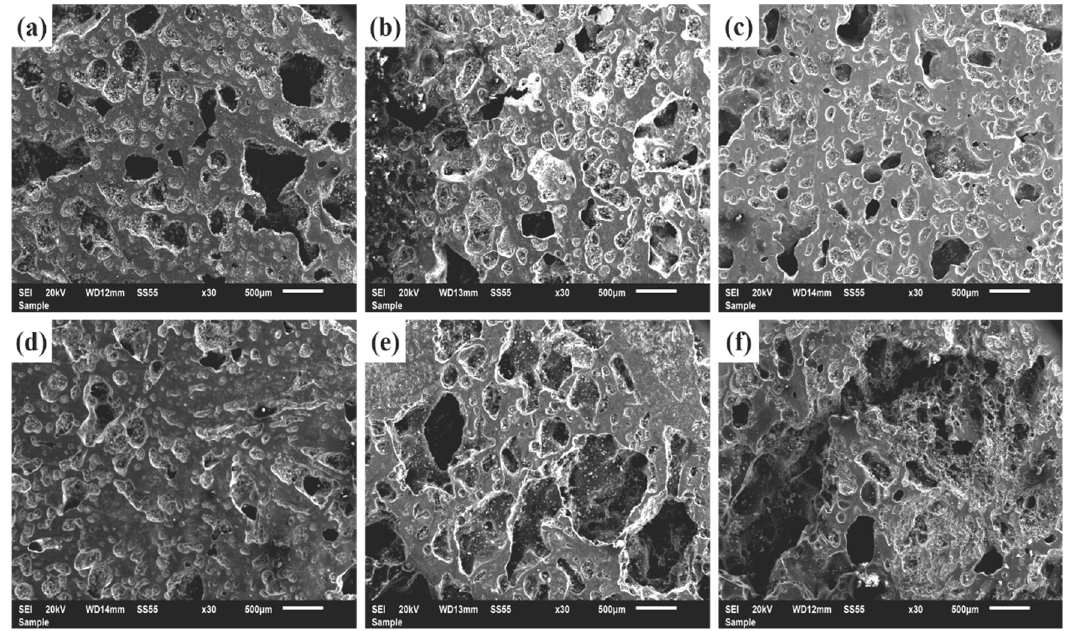
Figure 7. Micromorphology of coke after melting loss under CO 2 and H 2 O conditions. ( a ) Original sample; ( b ) 100%CO 2 ; ( c ) 25%CO 2 + 75%H 2 O; ( d ) 50%CO 2 + 50%H 2 O; ( e ) 75%CO 2 + 25%H 2 O; ( f ) 100%H 2 O.